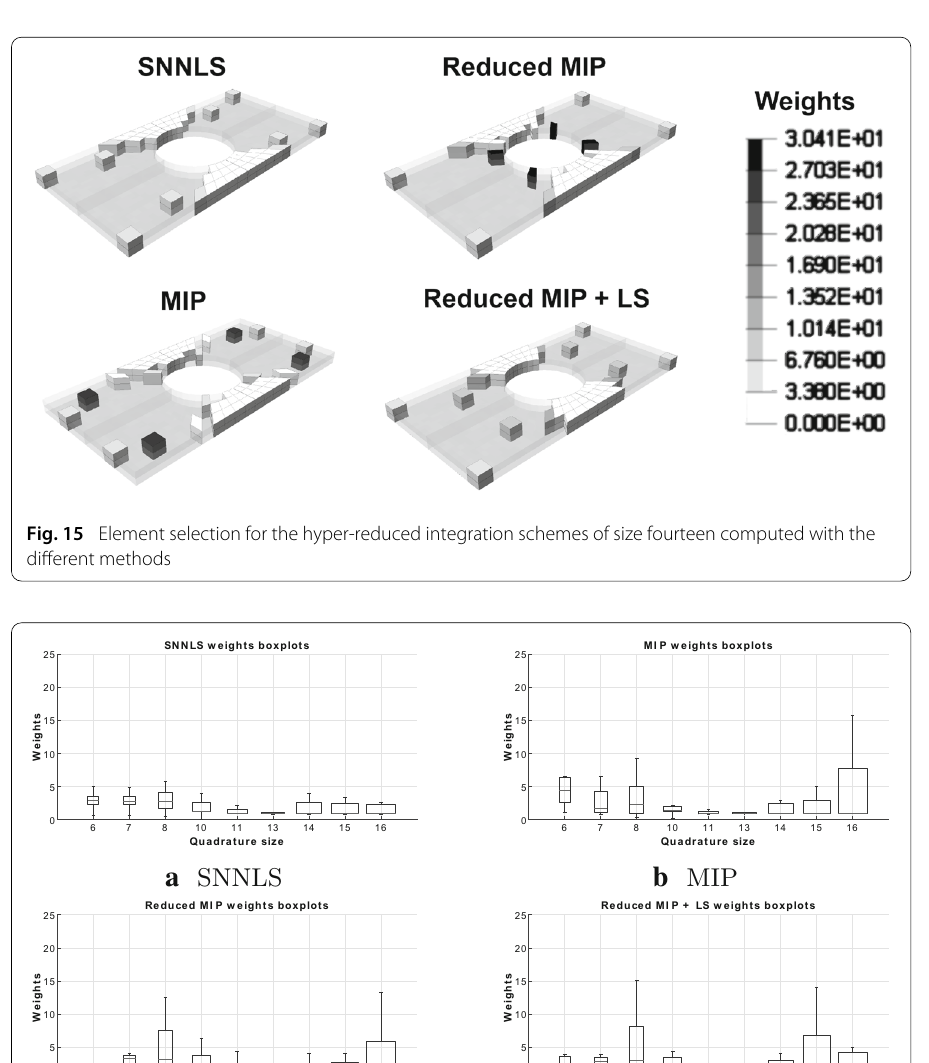
hole. By contrast with the proposed method, the SNNLS does not deselect elements when quadrature size increases, leading to different quadratures for similar prescribed precision in the learning phase. Differences are more visible on intermediate-size quadratures. In Fig. 15, Reduced MIP and the Reduced MIP + LS did not select the same elements. Obviously, when all elements are selected, results are the same for all methods. The Reduced MIP + LS solution corresponds, in fact, to the Reduced MIP for 15 elements in which one element has been unselected by the single pass in the SNNLS